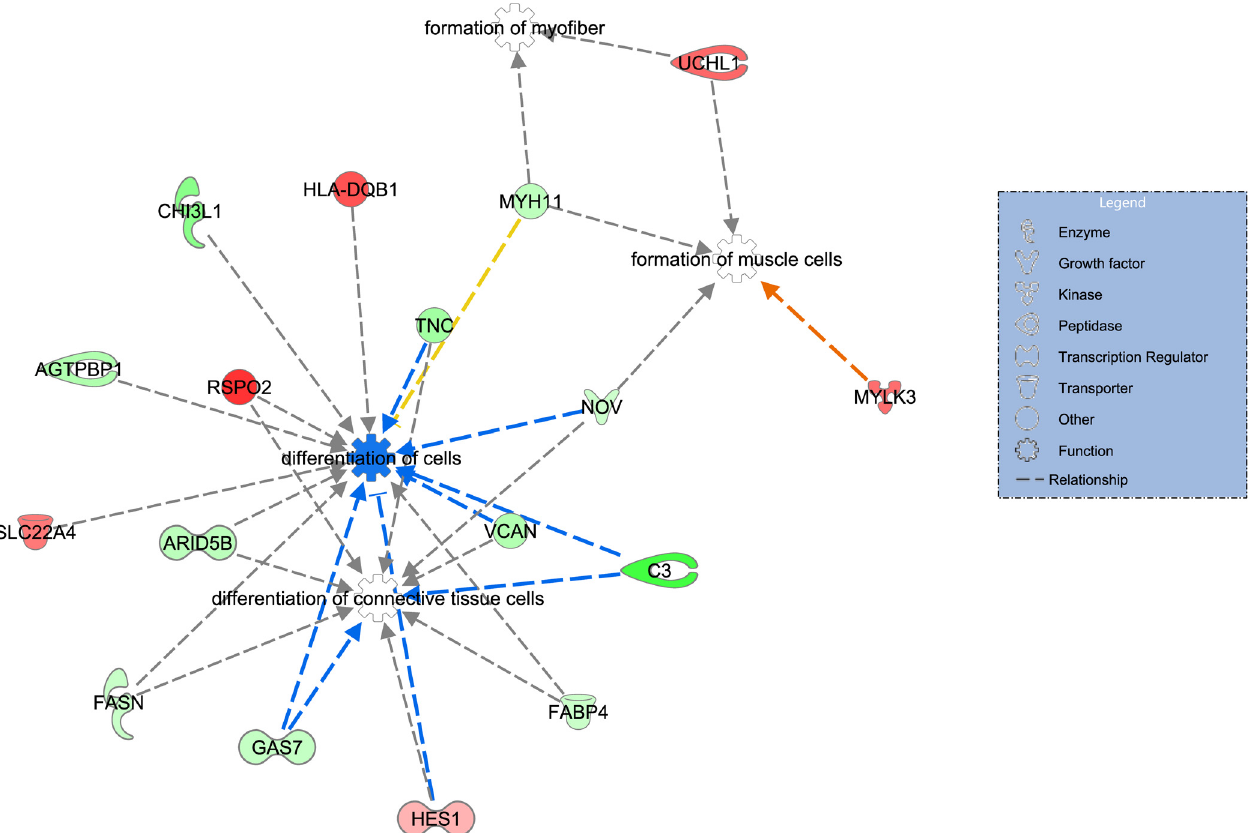
Fig 3. Cell development and a differentiation-related network of differentially expressed genes between high and low iron content in the Nelore steers Longissimus dorsi muscle. Genes presented in green and red are down- and up-regulated in the LowFe group, respectively. Color intensity refers to fold change estimates. Dotted arrows represent indirect interactions, and colors orange, blue, gray, and yellow denote activation, inhibition, unpredicted effect, and inconsistent effect, respectively. Reprinted from [QIAGEN ’ s Ingenuity 1 Pathways Analysis] under